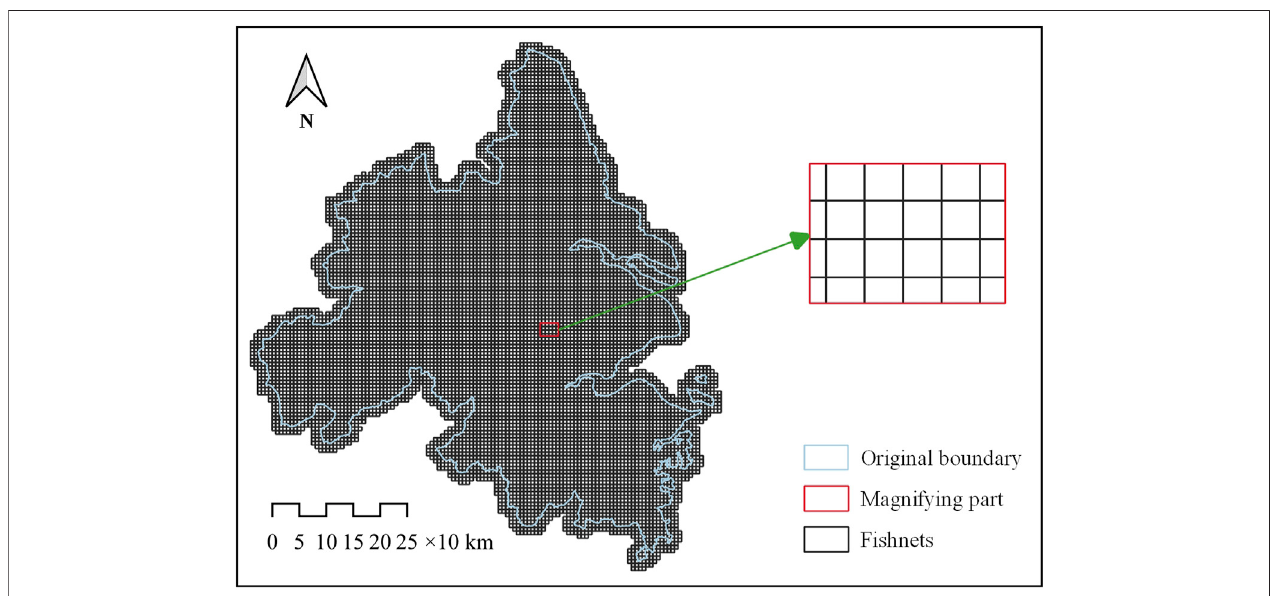
FIGURE 2 | Fishnets in the